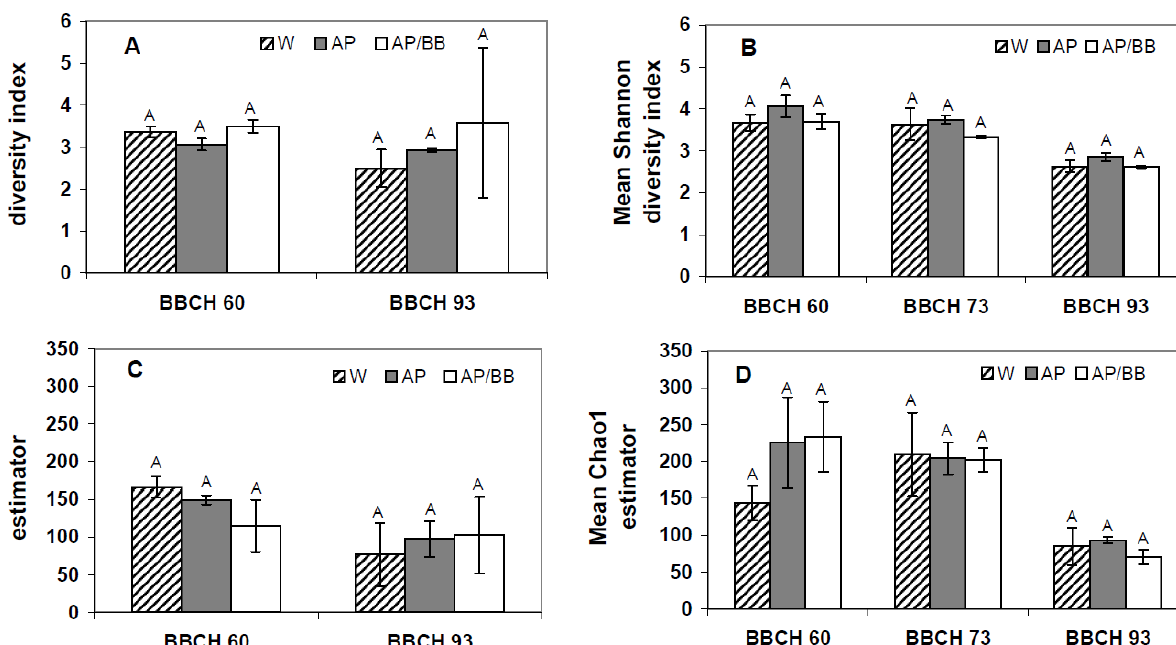
Figure 6. Shannon diversity indices and Chao1 estimators describing the biodiversity and taxa richness of bacterial phyllosphere communities at three distinct phenological stages (BBCH 60, BBCH 73, and BBCH 93) as influenced by treatments with Aureobasidium pullulans as a single treatment (AP) or co-inoculated with Beauveria bassiana (AP/BB) in 2011 ( A , C ) and 2012 ( B , D ). The control (W) was treated with water from a lotic reservoir. Error bars represent SEM values. Columns marked with the same letters are not significantly different within each phenological stage ( α =